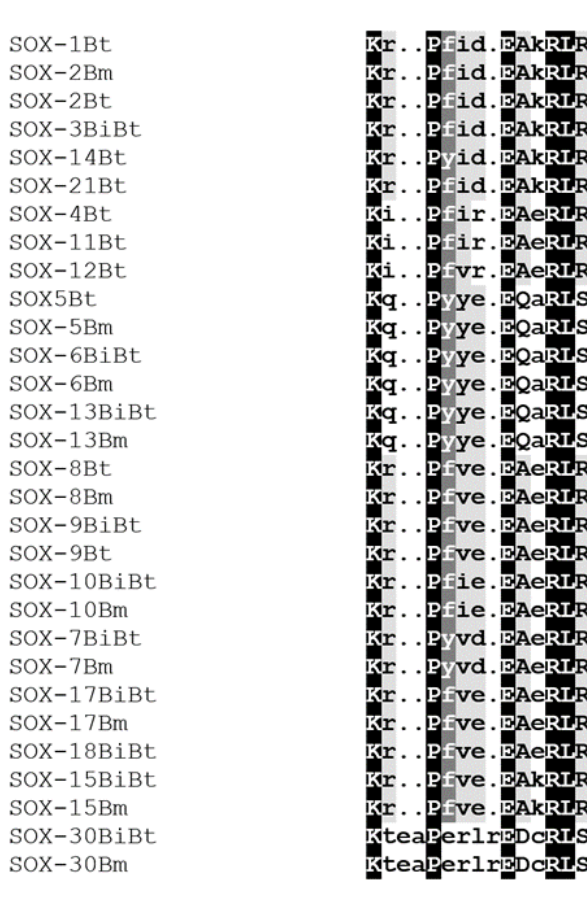
Figure 3. ( a ) Rooted phylogeny of Sox genes in Bos sp. computed using the neighbor-joining method (MEGA). ( b ) Unrooted phylogeny of Sox genes created by the interactive tree of life (ITOL) online software (https://itol.embl.de accessed on 3 June 2022) which assigned color to the different subfamilies. The various subfamilies (A, B1, B2, C, D, E, F, G and H) are highlighted in different colors.